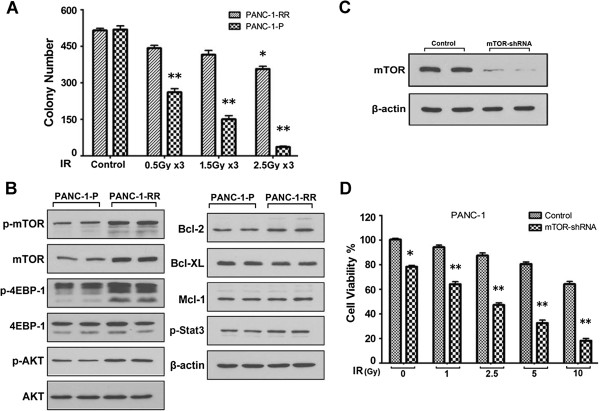
mTOR play a critical role in pancreatic cancer radioresistance. (A) Parental PANC-1 (PANC-1-P) and radiation resistant PANC-1 cells (PANC-1-RR) were treated with increasing doses of radiation and cultured for 10 days, cell growth was analyzed by colony formation assay and the data were statistically analyzed. The experiment was repeated three times and the number of colonies was presented as mean ± SD. *, P < 0.05 vs. control and **, P < 0.01 vs. control and PANC-1-RR cells. (B) Expression and/or phosphorylation of mTOR, Akt, 4EBP1, Bcl-2, Bcl-XL and Mcl-1 in PANC-1-P and PANC-1-RR cells were analyzed by Western blot. (C) mTOR shRNA and control were transfected into PANC-1 cells and mTOR expression was analyzed by Western blot. (D) Cells were transfected and then treated with increasing doses of radiation for 48 h, cell viability was analyzed by SRB assay. Error bars represent ± S.D. *, P < 0.05 vs. vector-only control and **, P < 0.01 vs. vector-only control.